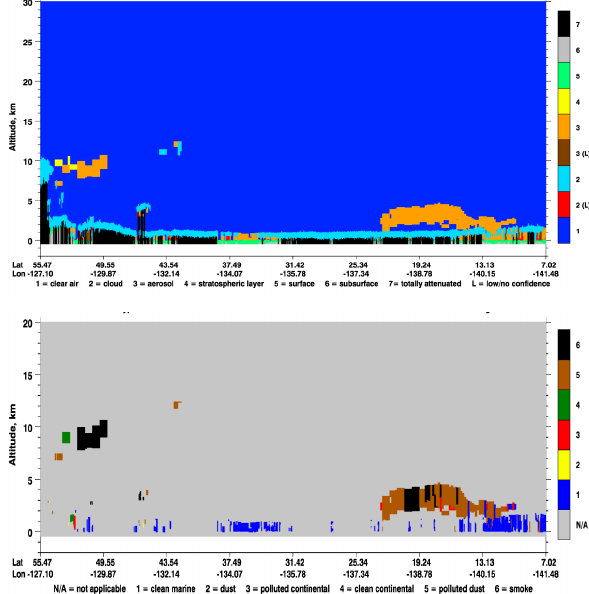
Fig. 13. CALIPSO vertical feature mask (top) and aerosol subtype (bottom) plots near CORALNet UBC on 24 June at approxi- mately 11:00UTC (http://www-calipso.larc.nasa.gov/products/ lidar/browse images/show date.php?s=production \ &v=V3-01 \ &browse